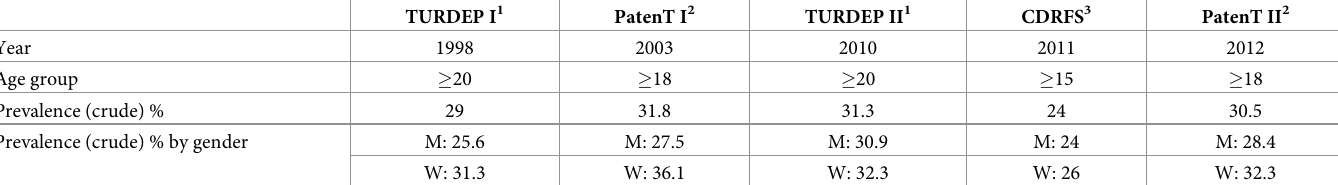
Table 1. Surveys of hypertension prevalence in Turkey.